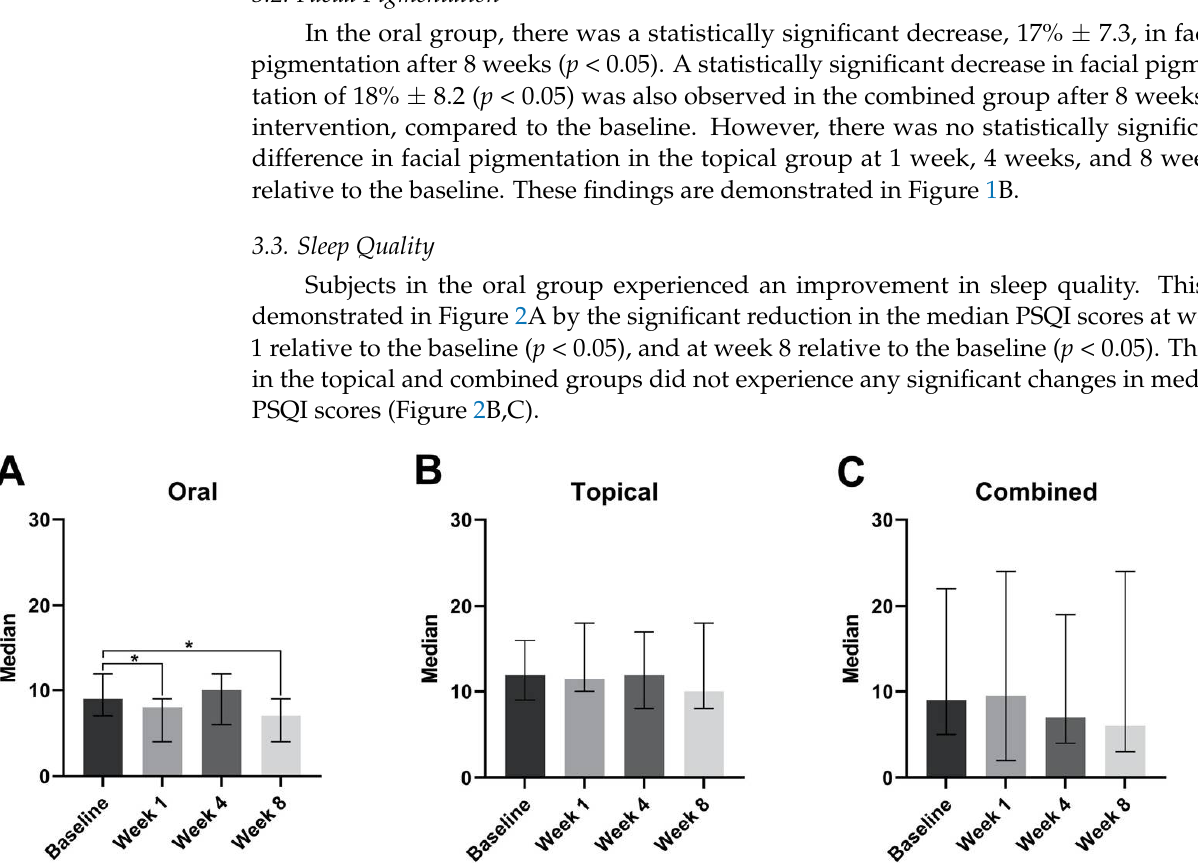
Figure 2. Median PSQI scores at the baseline, week 1, week 4, and week 8, with the oral ( A ), topical ( B ), or combined groups ( C ). * p < 0.05.